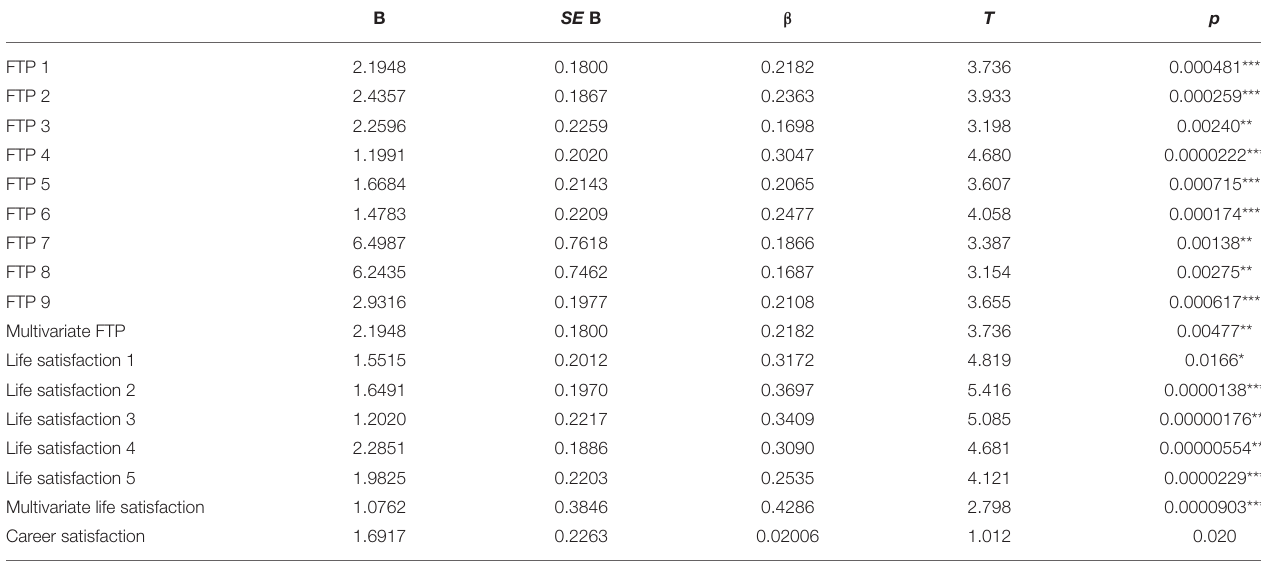
TABLE 4 | Logistic regression between the question “how close is your relationship with your friends?” and measures of future time perspective (FTP), life satisfaction, and career satisfaction. B SE B β